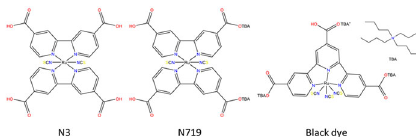
Fig. 2 Molecular structures of ruthenium-based dyes: N3, N719 and Black dye.